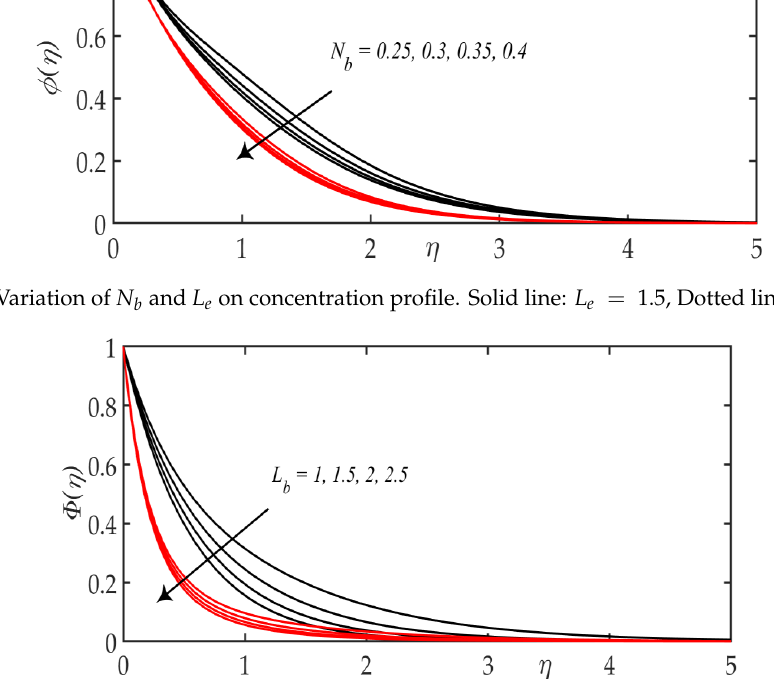
Figure 10. Variation of 𝑃 𝑒 and 𝐿 𝑏 on microorganism profile. Solid line: 𝑃 𝑒 = 0.5 , Dotted line: 𝑃 𝑒 = 2.0.